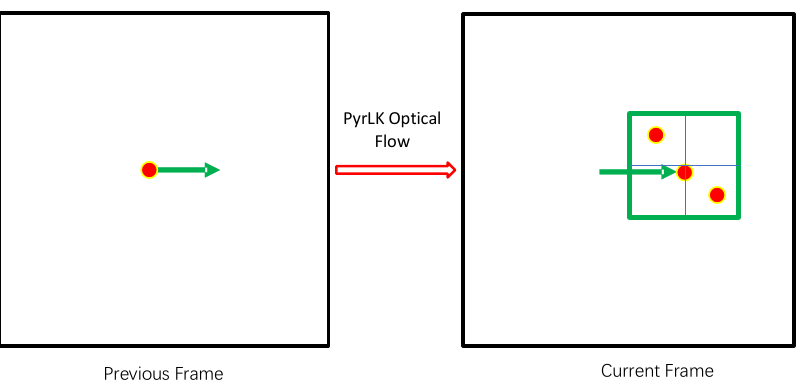
Figure 5. The optical flow algorithm is performed on the feature points tracking